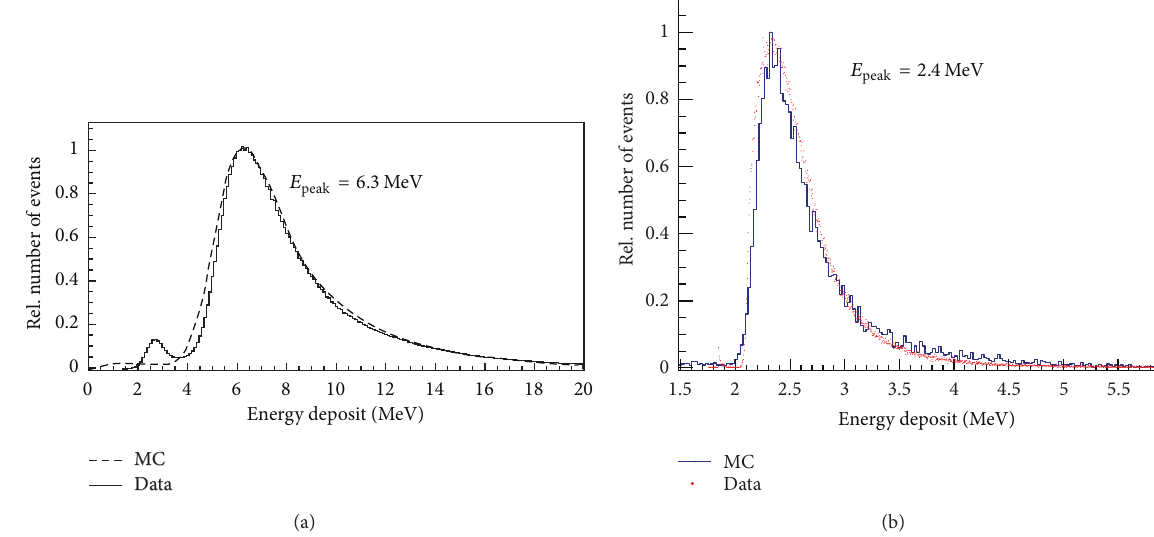
Figure 3: (a) The energy calibration for one scintillator plate of the previous configuration, made by comparing the measured energy deposit spectrum of the minimum ionizing particles with GEANT 3.21 [28] simulated one. (b) The energy calibration for one scintillator sheet of the recent detector setup, made by comparison of the measured energy deposit spectrum of the minimum ionizing particles with GEANT 4.94 [29] simulated one.